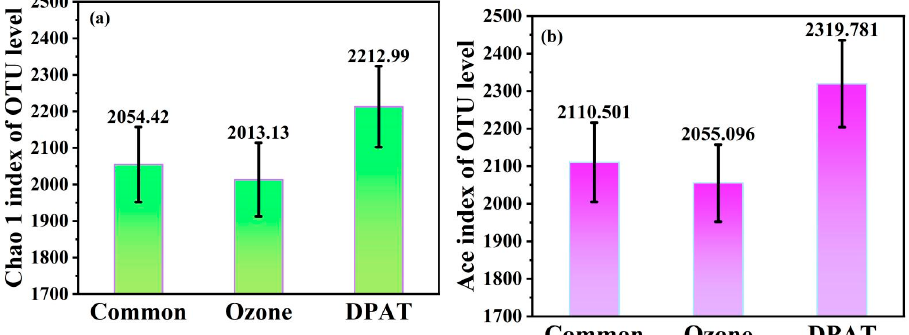
Figure 5. The microbial abundance in the activated sludge samples evaluated by the chao1 index ( a ) and the ace index ( b ).